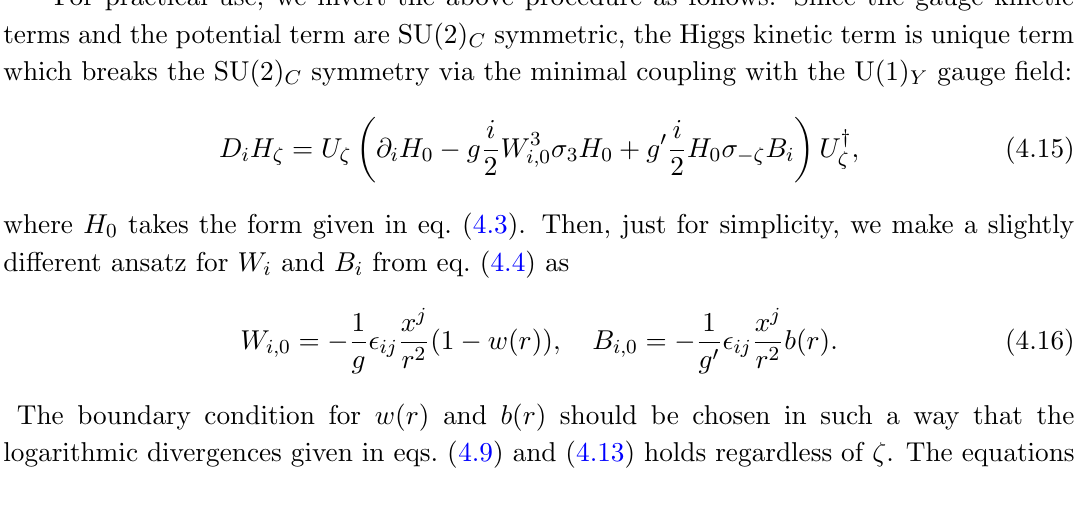
2 , and 1. We (cid:12)x the other parameter by requiring ~ (cid:13) 1 80 ; 2 91 (cid:0) (cid:1)